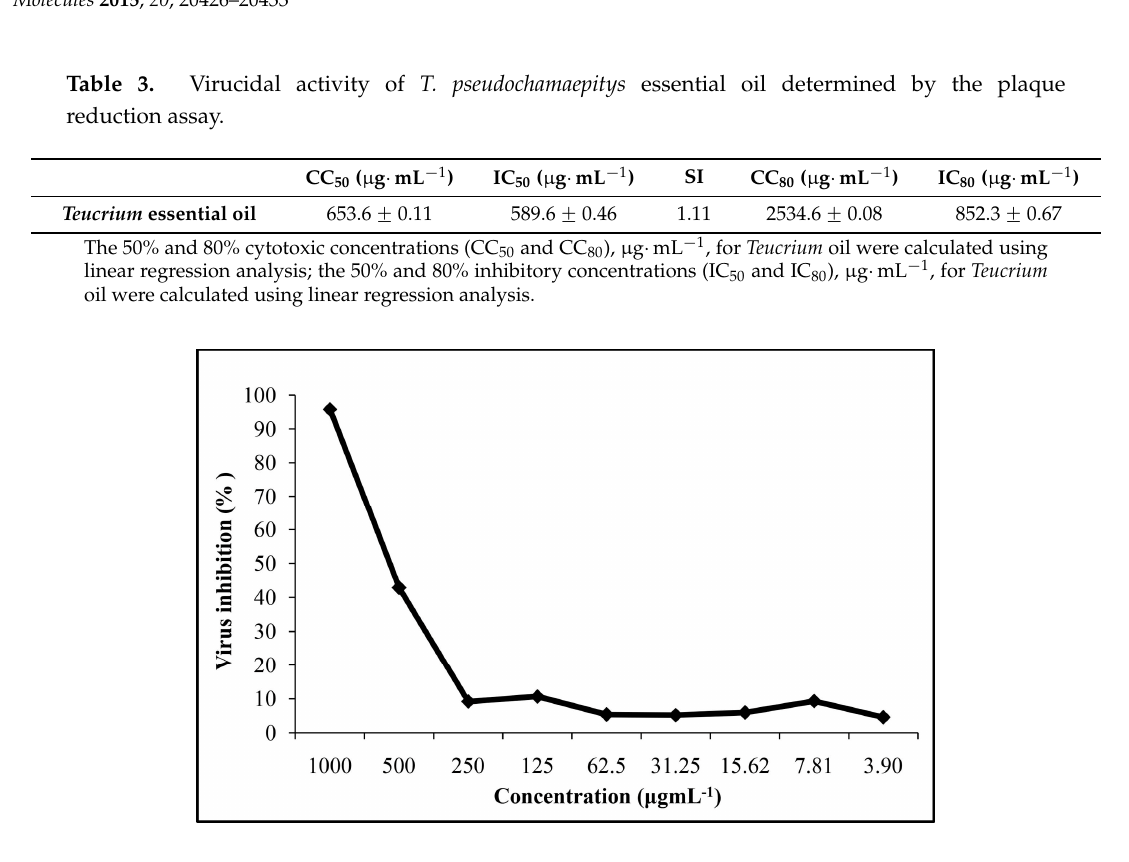
Figure 2. Antiviral activity of Teucrium pseudochamaepitys .